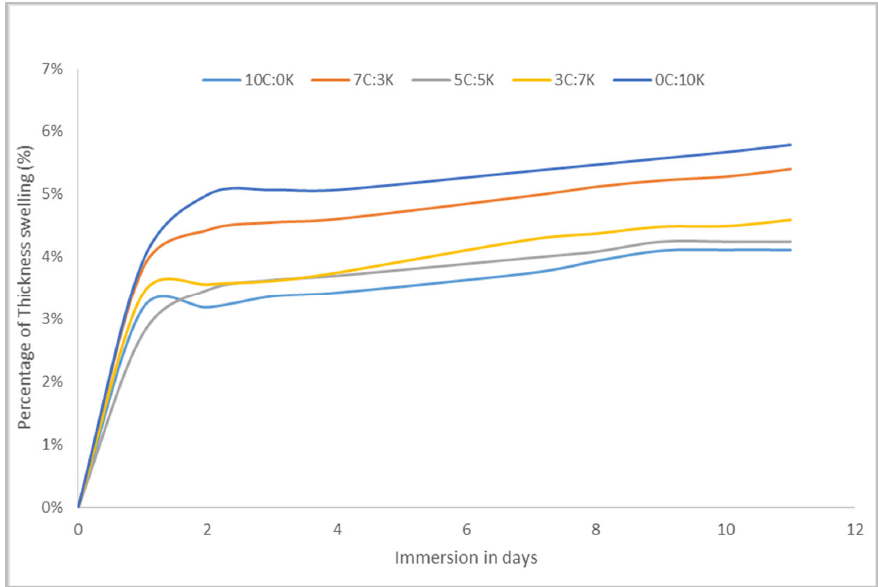
Figure 3. Thickness swelling percentage of CR and/or kenaf reinforced phenolic composites.